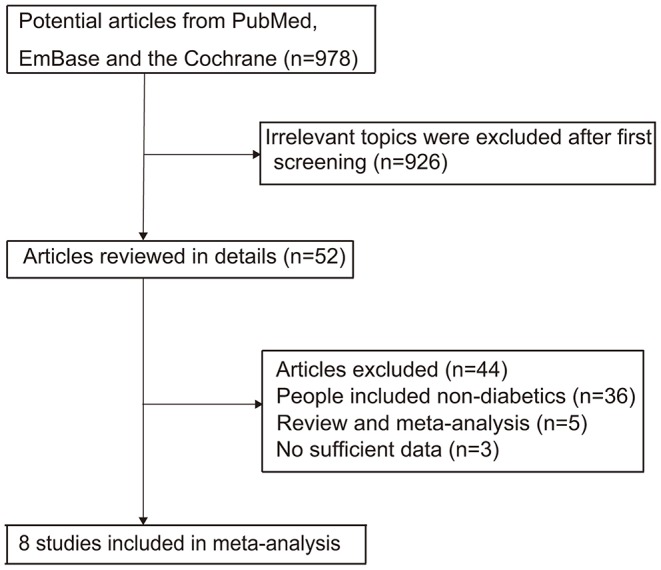
The flowchart of the study selection process.